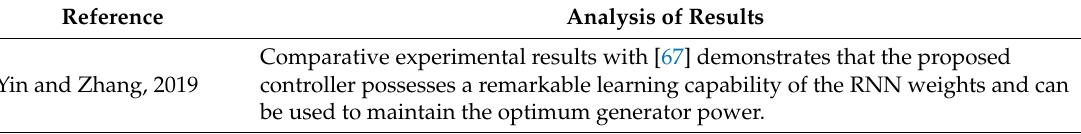
Table 3. Summary with ANN algorithms for MPPT for wind